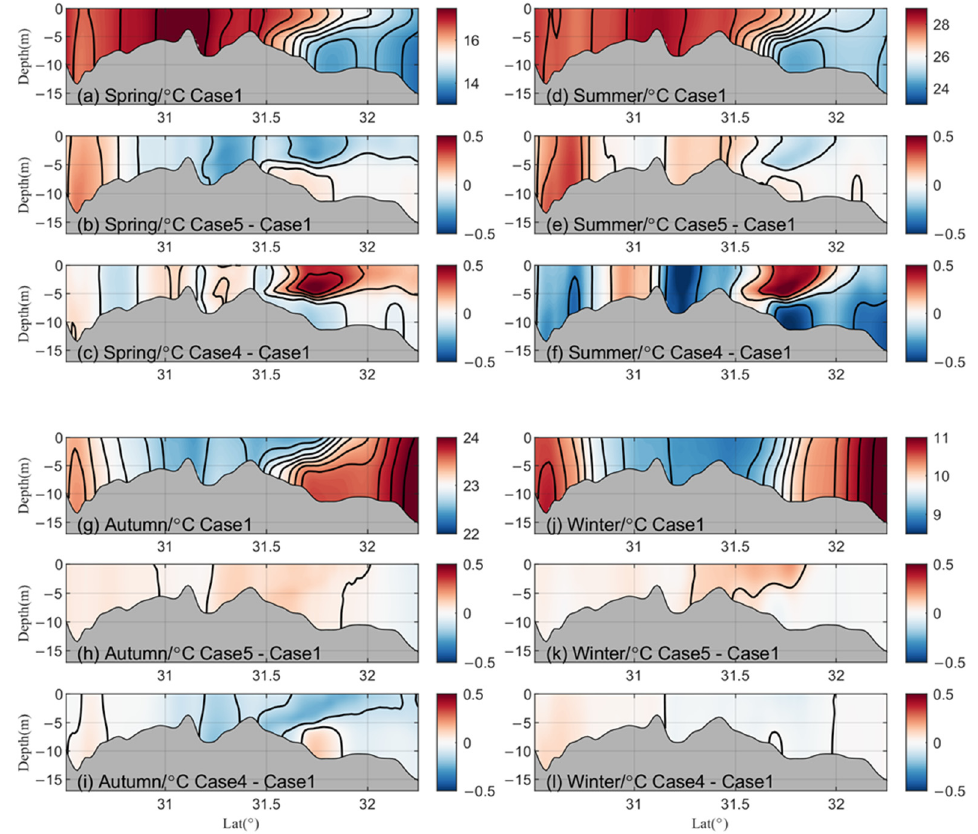
Figure 10. The sectional distribution of sea temperature (°C, 122.2° N). ( a , d , g , j ) (case 1 results in Spring, Summer, Autumn and Winter); ( b , e , h , k ) (the difference between case 1 and case 5 in Spring, Summer, Autumn and Winter); ( c , f , i , l ) (the difference between case 1 and case 4 in Spring, Summer, Autumn and Winter).